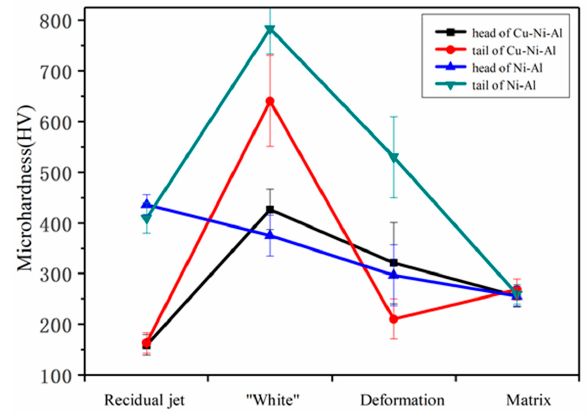
Figure 11. The Vickers hardness values for all zones.